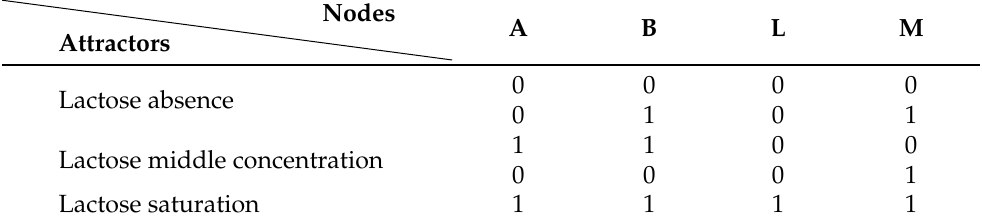
Table 7. Attractors of the network of Equation (20). Every row represents an attractor state.